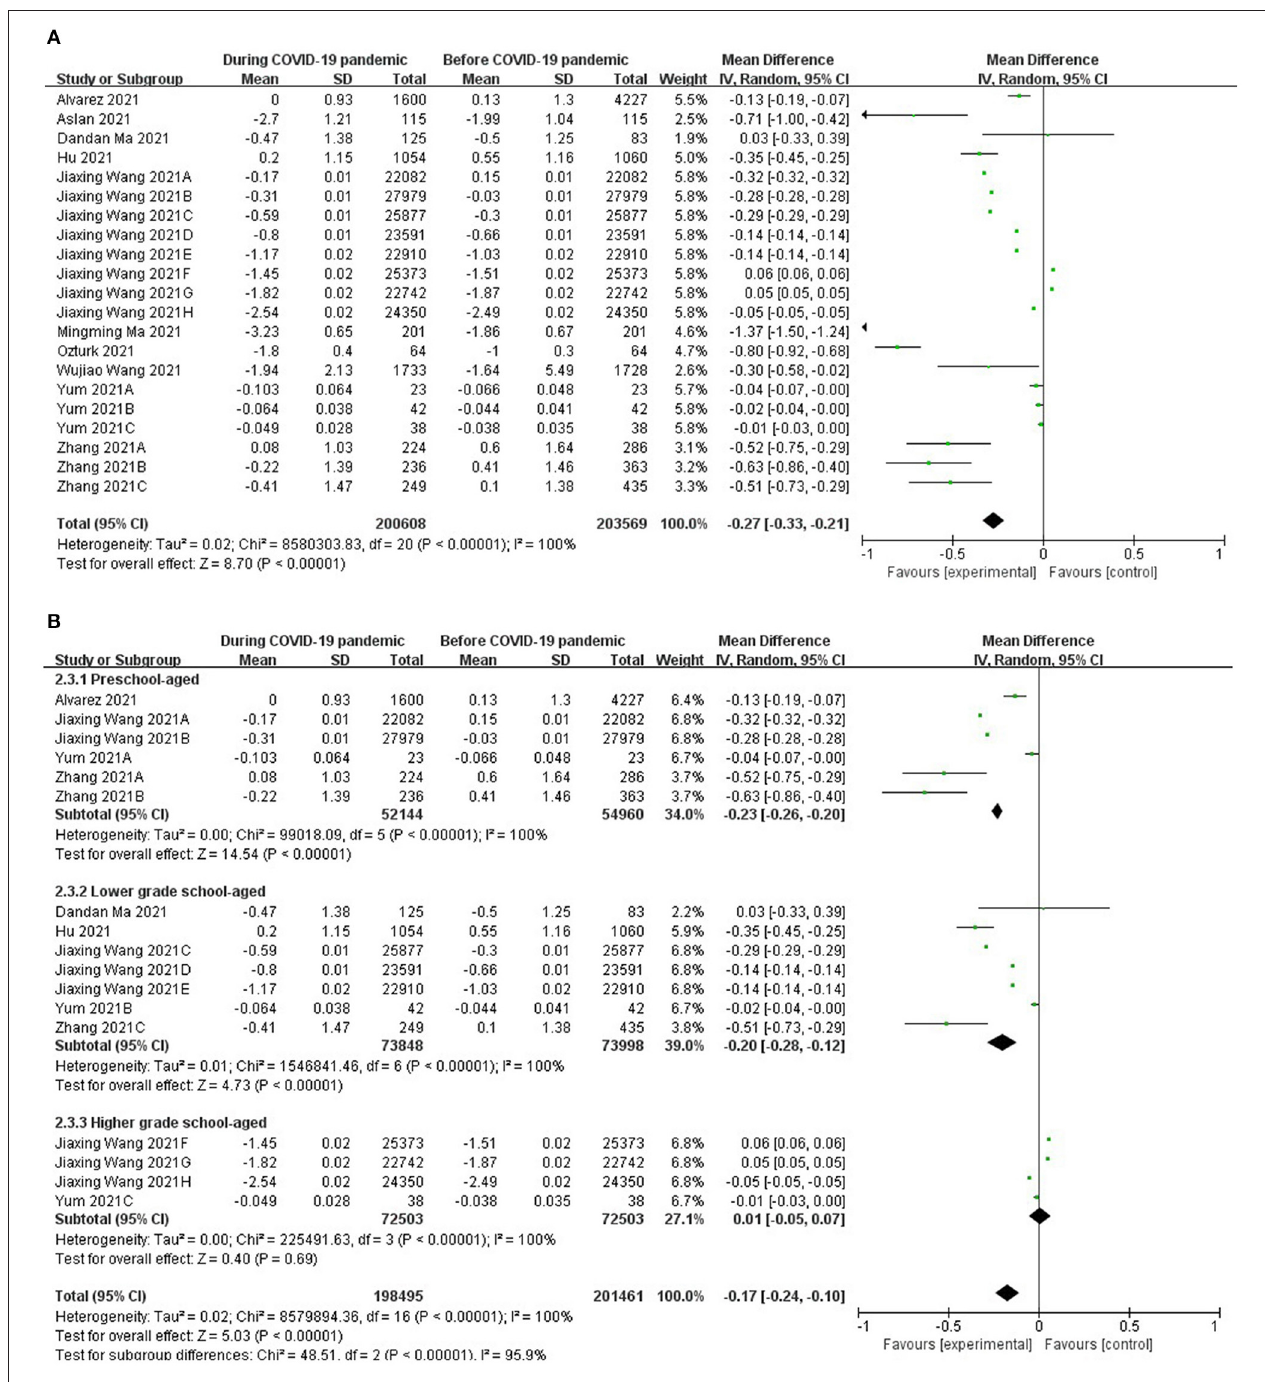
FIGURE 3 | (A) Forest plots for comparison of spherical equivalent refraction between COVID-19 pandemic and before it. (B) Forest plots and subgroup analysis for comparison of spherical equivalent refraction between COVID-19 pandemic and before it.